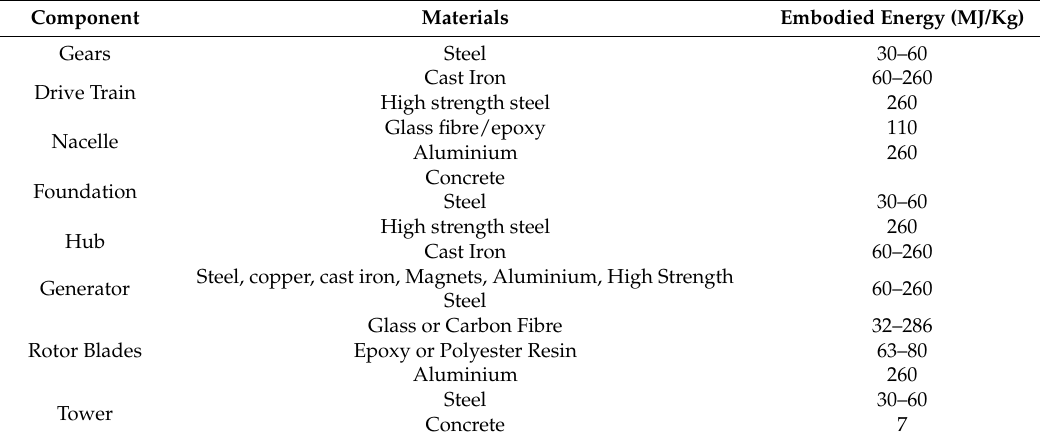
Table 1. Materials used for wind turbines with corresponding embodied energies [21–41].